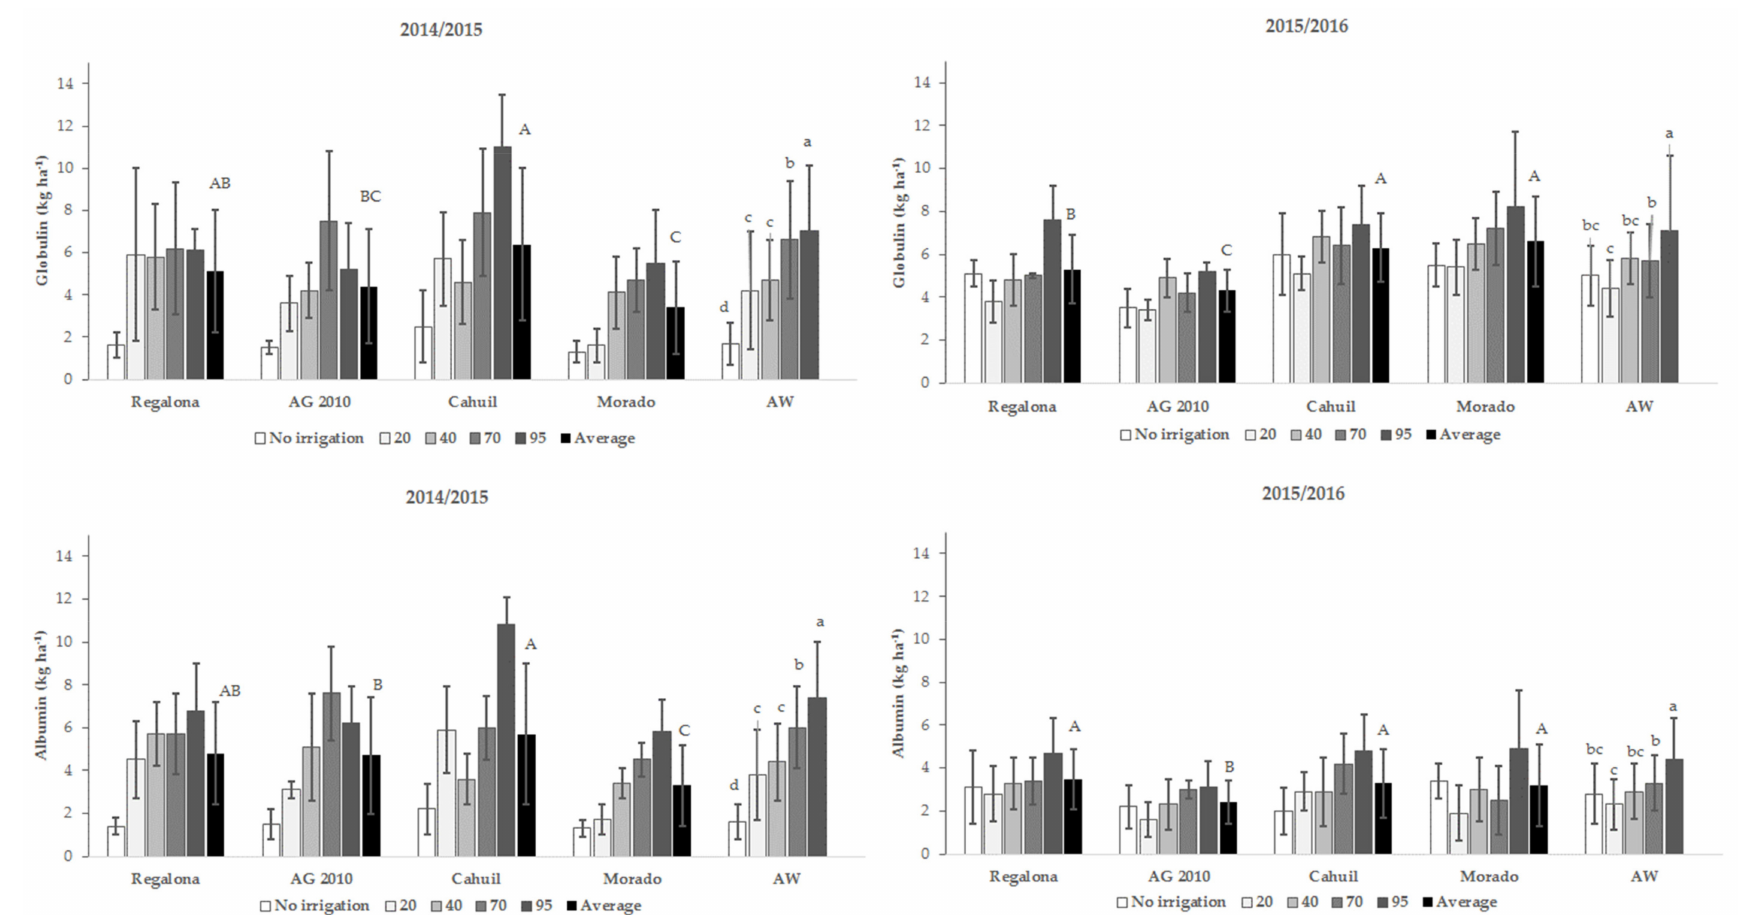
Figure 3. Globulin (Globu) and albumin (Album) yield in quinoa seeds subjected to different water deficit conditions in the 2014/2015 and 2015/2016 seasons. Different lowercase letters indicate significant difference between water deficit conditions ( p ≤ 0.05). Different capital letters are significant difference between genotype ( p ≤